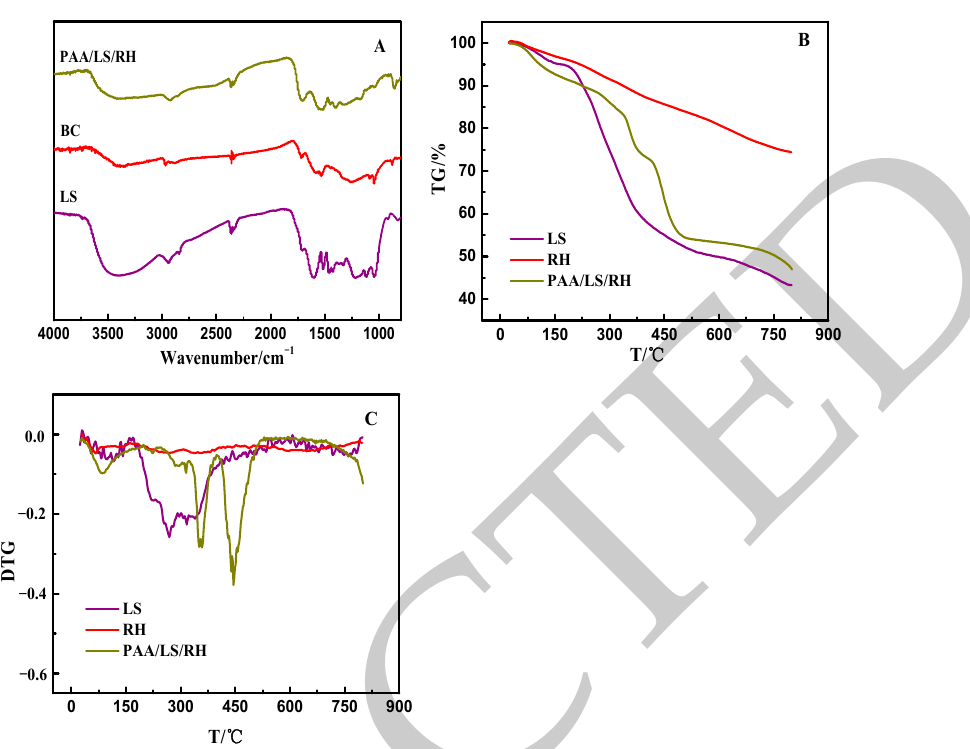
Figure 2. FTIR spectra of LS, BC, and PAA/LS/BC ( A ); TG (thermogravimetry) ( B ) and DTG (differential thermogravimetry) ( C ) curves of LS, BC, and PAA/LS/BC.